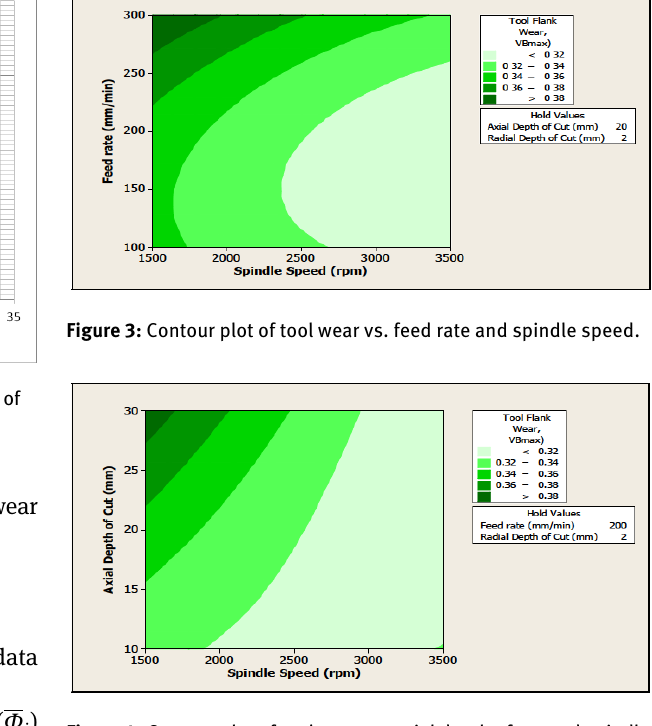
Figure 4: Contour plot of tool wear vs. axial depth of cut and spindle